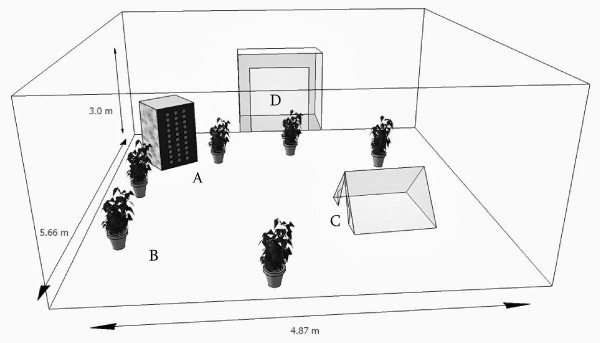
Diagram of the mesocosm, with A) bank of resting sites, B) Senna didymobotrya plants, C) sleeping pad and mesh netting D) antechamber.